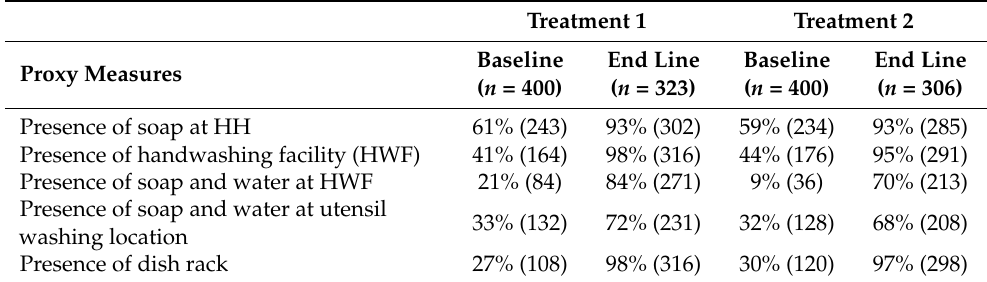
Table 4. Proxy measures compared between treatment 1 and treatment 2 at baseline (2017) and end line (2018)) Adapted with permission from [17]. ©2020, Morse